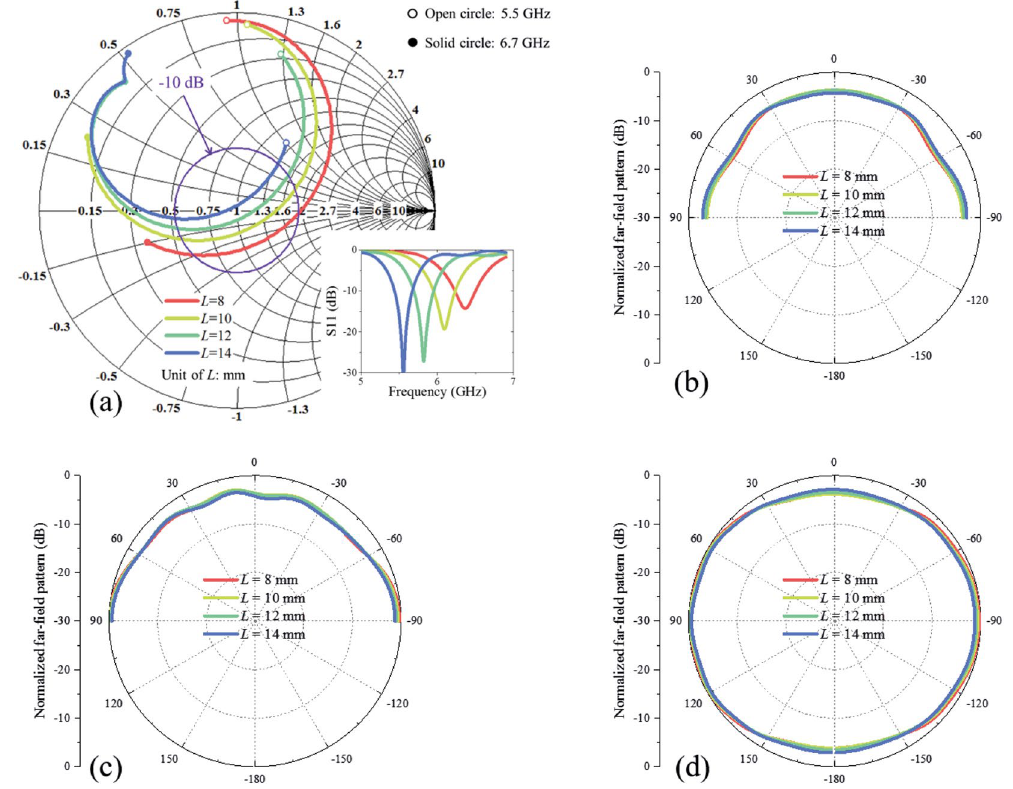
Figure 6. Relations between structure parameter L and antenna performances. ( a ) Impedance matching versus L . The insert figure shows reflection coefficients corresponding to different L . Normalized radiation patterns in xz plane, yz plane, and xy plane at 5.8 GHz versus L are shown in ( b – d ), respectively. Resonant frequency decreases with L and radiation patterns change little with L